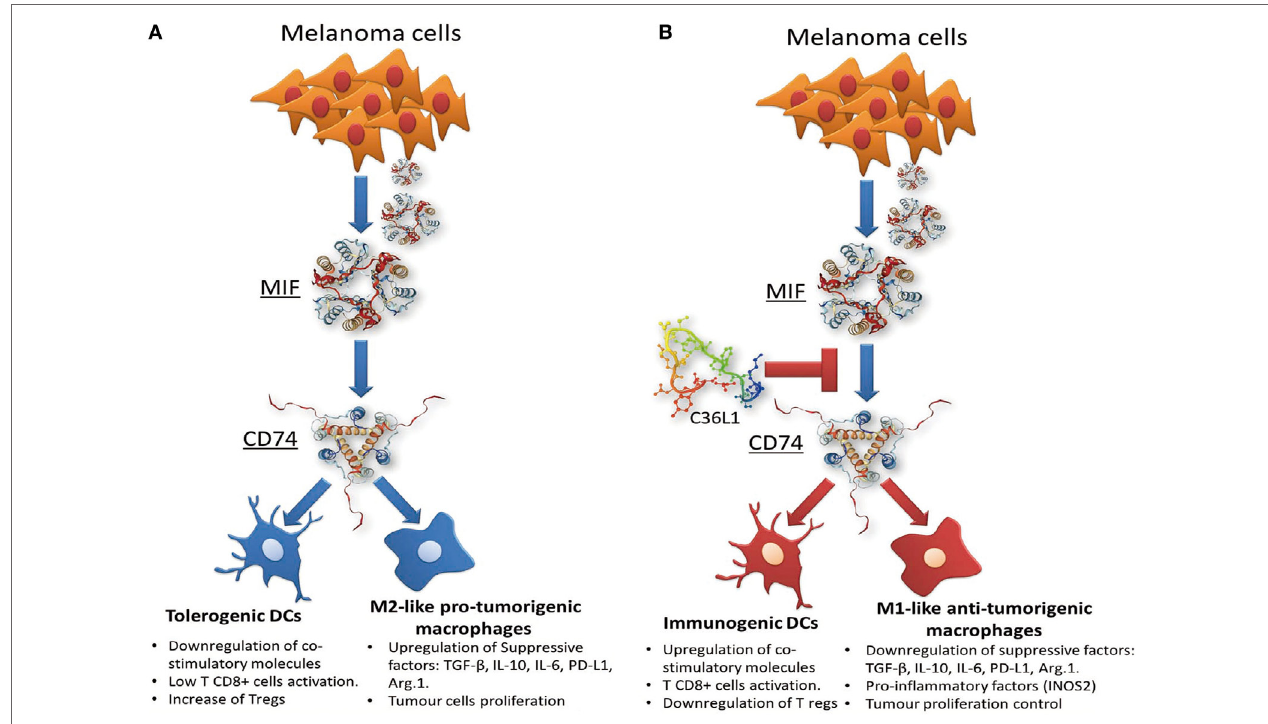
FigUre 7 | Scheme of the mechanism of action of the C36L1 peptide in macrophages (MOs) and dendritic cells (DCs). C36L1 binds to receptor of macrophage migration inhibitory factor (MIF) CD74, thereby blocking its immunosuppressive effect on MOs and DCs (a) , restoring their antitumorigenic functions and their capacity to activate and support an effective immune response against metastatic melanoma (B)